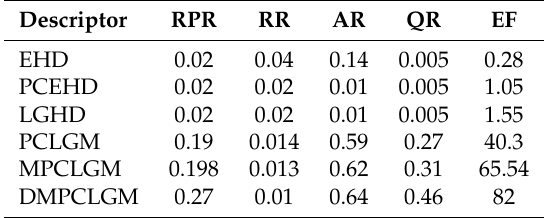
Table 1. Comparison of the six algorithms using the RGB-LWIR data set.